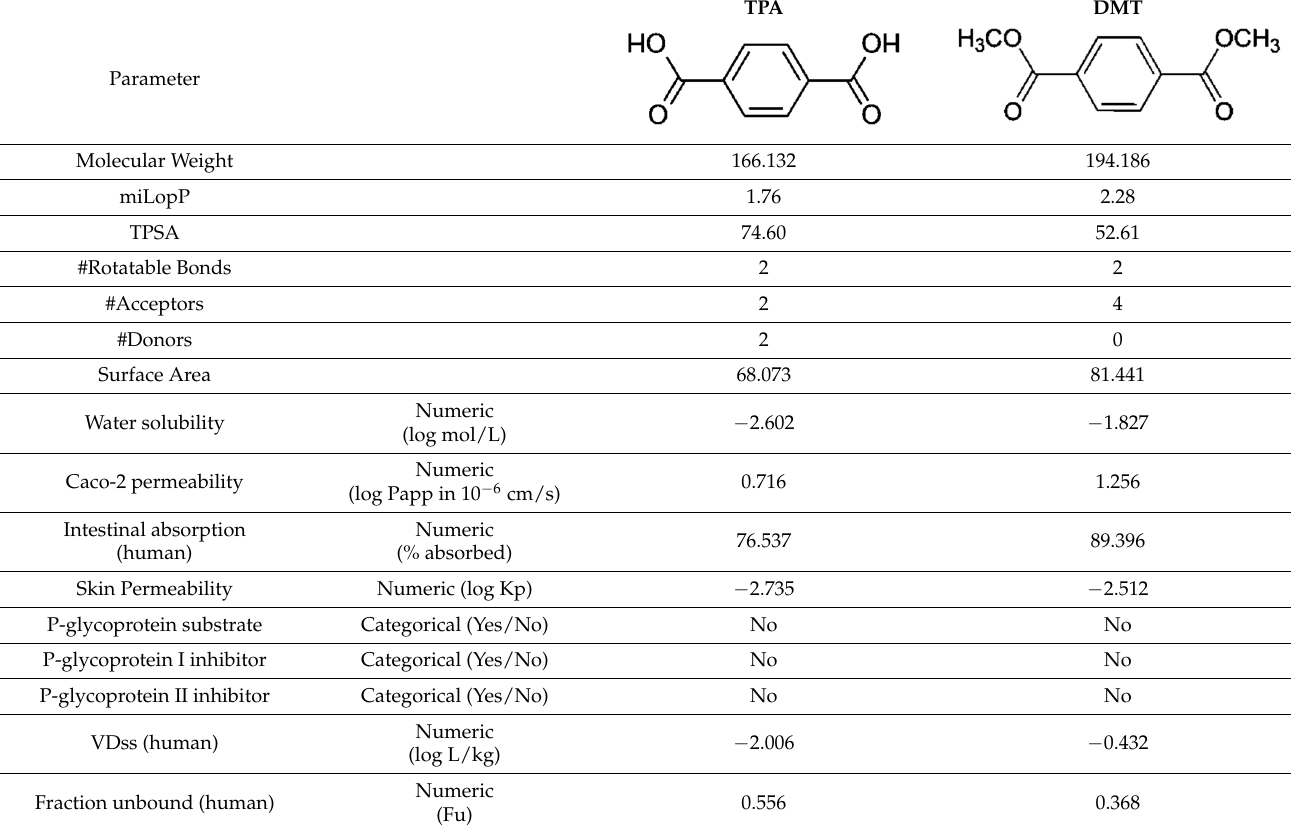
Table 1. In silico physicochemical and pharmacokinetic parameters of TPA and DMT.